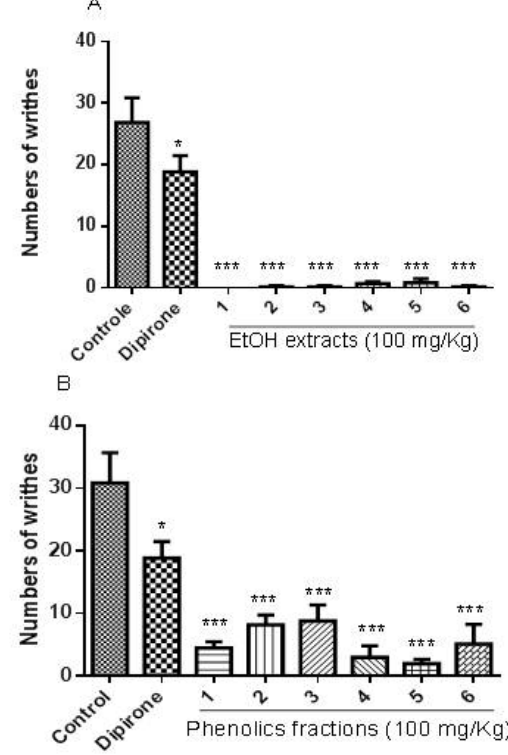
Fig 2. Effects of injections of ethanolic extract of geopropolis and phenolic fractions on abdominal constriction induced by acetic acid in mice. Control groups included the mice treated with only vehicle (negative control) or dypirone (positive control) 40 min before initiating nociceptive stimulus. Data are expressed as the mean ± SEM, n=6. Symbols indicate significant differences (*P<0.05 and * **P<0.001, One Way ANOVA followed by Dunnett’s test) compared to the control group.